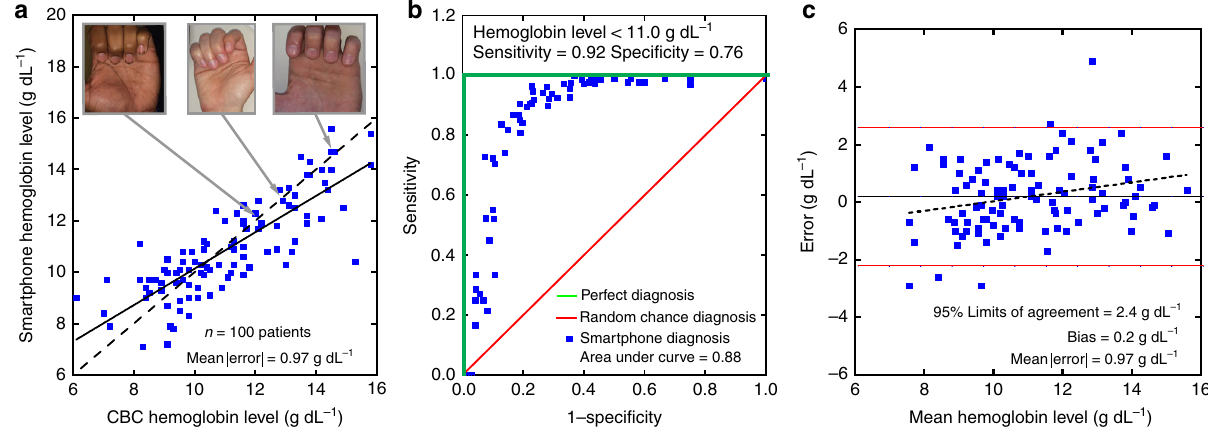
Fig. 2 The smartphone-based image analysis algorithm accurately measures Hgb levels. a The smartphone image analysis algorithm measures blood Hgb levels to within ±0.97 g dL − 1 of the CBC Hgb level ( r = 0.82, mean |error|). The solid line represents the ideal result where smartphone Hgb level is equal to the CBC Hgb level whereas the dashed line represents the actual data fi t. Inset images illustrate example patient-sourced photos that were used to calculate Hgb level measurements. b The receiver-operating characteristic (ROC) analysis graphically illustrates the algorithm ’ s diagnostic performance against a random chance diagnosis (red line), with an area under the curve of 0.5, and a perfect diagnostic (green lines), with an area under the curve of 1. In the case of this noninvasive smartphone app Hgb measurement system (black line), the area under the curve of 0.88 suggests viable diagnostic performance of this algorithm. When using the WHO Hgb level cutoff of < 12.5 g dL − 1 , the sensitivity of the test is 97% (95% CI, 89 – 100%), n = 100 patients. c Bland – Altman analysis reveals minimal experimental bias with 0.2 g dL − 1 average error, indicating that Hgb measurement is has a very small bias. The dashed line represents the relationship between the residual and the average of Hgb level measurements obtained from the CBC and the algorithm ( r = 0.26). The solid red lines represent 95% limits of agreement (±2.4 g dL − 1 ). n = 100